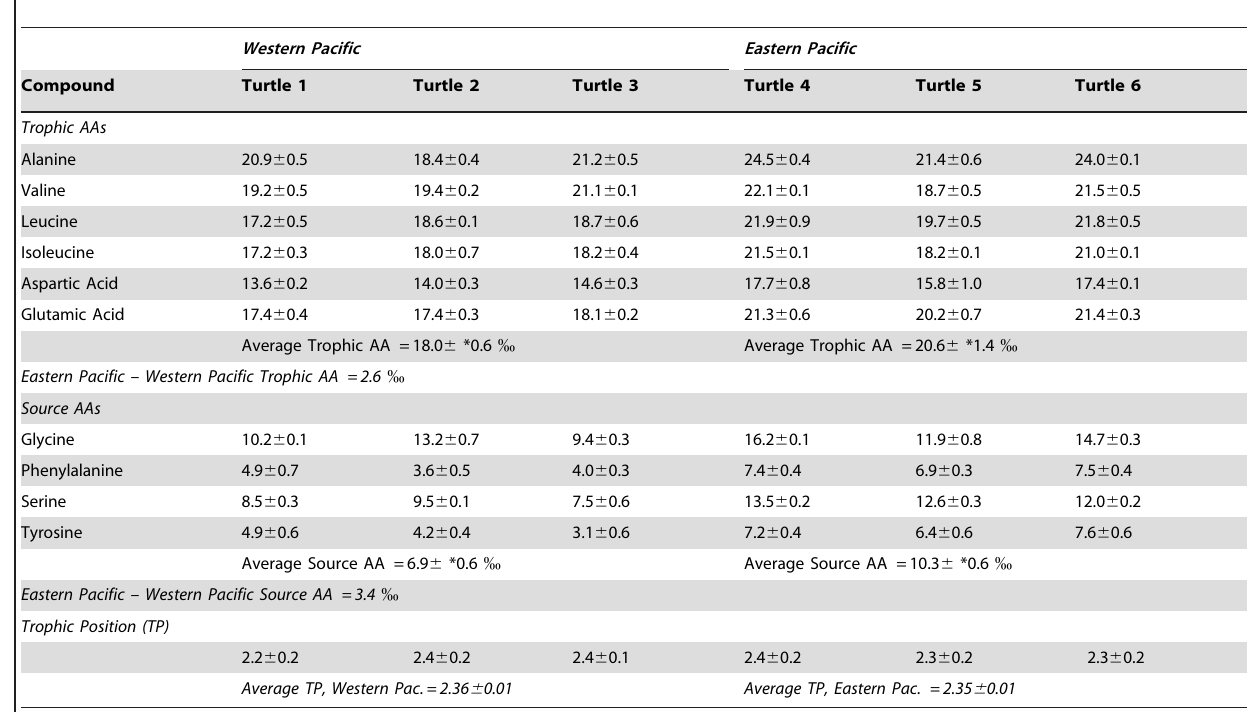
Table 2. d 15 N values ( % ) of source and trophic amino acids in leatherback turtles known from satellite tracking to migrate to the western and eastern Pacific